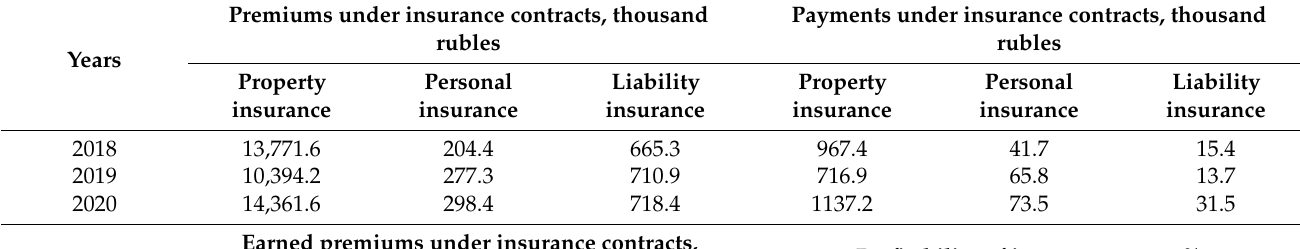
Table 3. The average profitability of Renaissance Insurance from